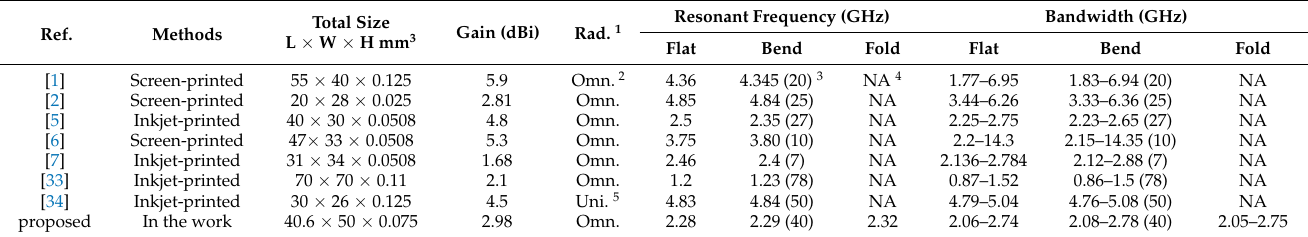
Table 5. Comparison of different fabrication methods of flexible antennas on polyimide substrates.